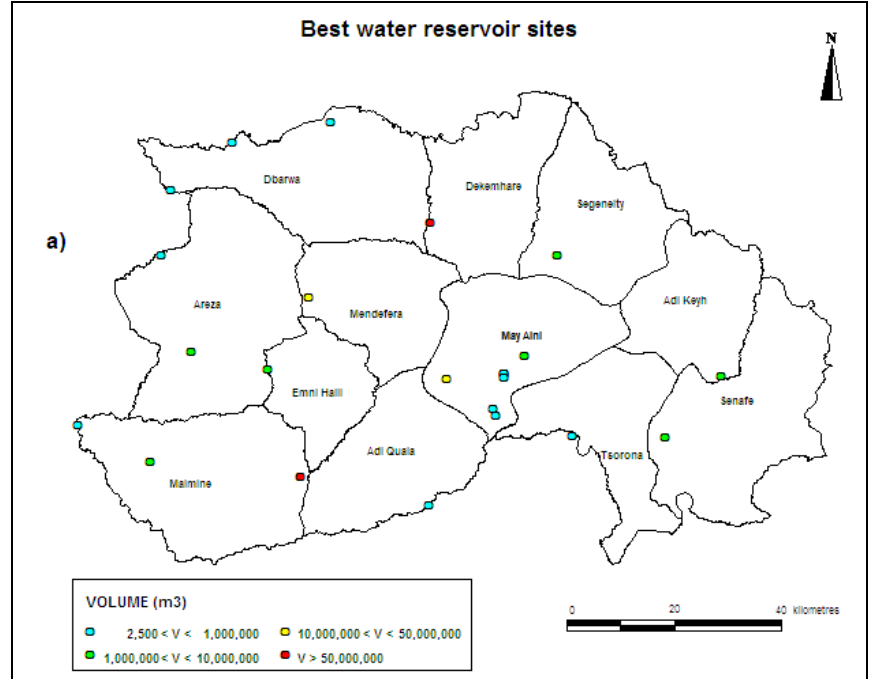
Figure 11. (a) Best water reservoir sites; and (b) Good water reservoir